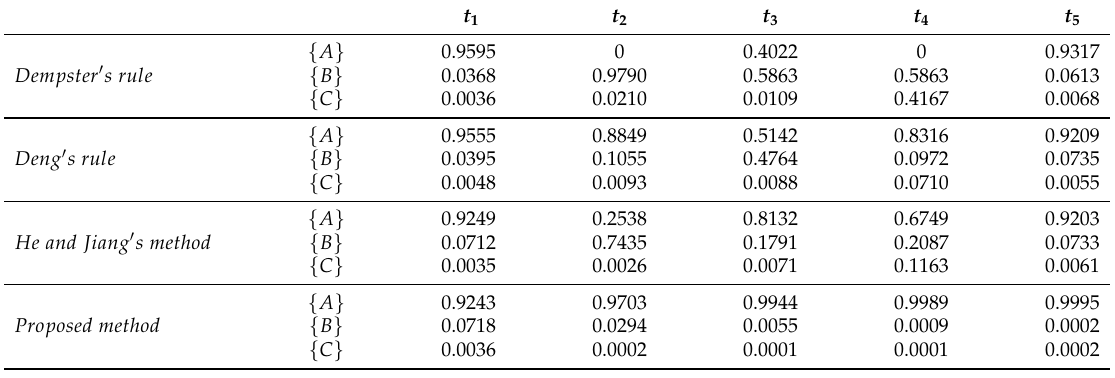
Table 4. Simulation results of four methods when the target moves along a straight line.